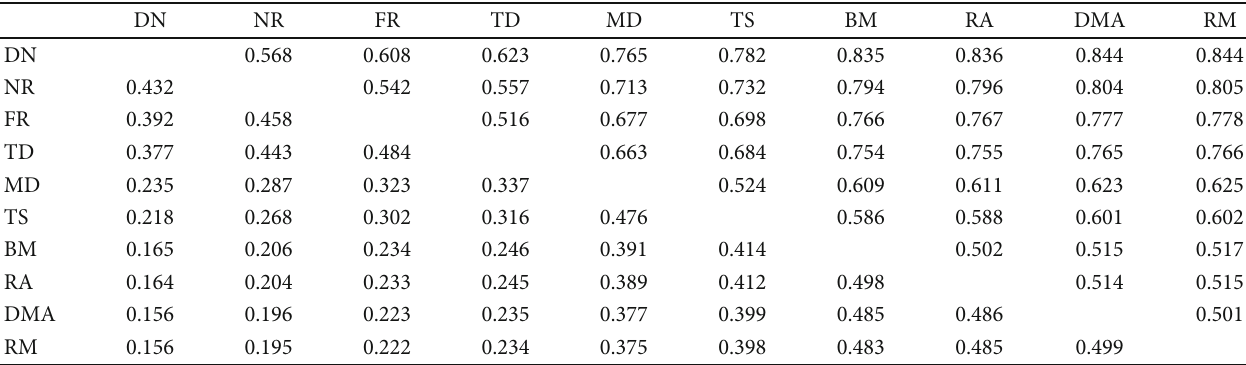
Djokovic N. Tsitsipas S. Rublev A. Wawrinka S. Figure 2: Estimated relative abilities of tennis players on all surfaces. Table 2: Wining probabilities of players on all surfaces. DN: Djokovic N.; NR: Nadal R.; FR: Federer R.; TD: Thiem D.; MD: Medvedev D.; TS: Tsitsipas S.; ZA: Zverev A.; BM: Berrettini M.; DMA: De Minaur A.; RM: Raonic